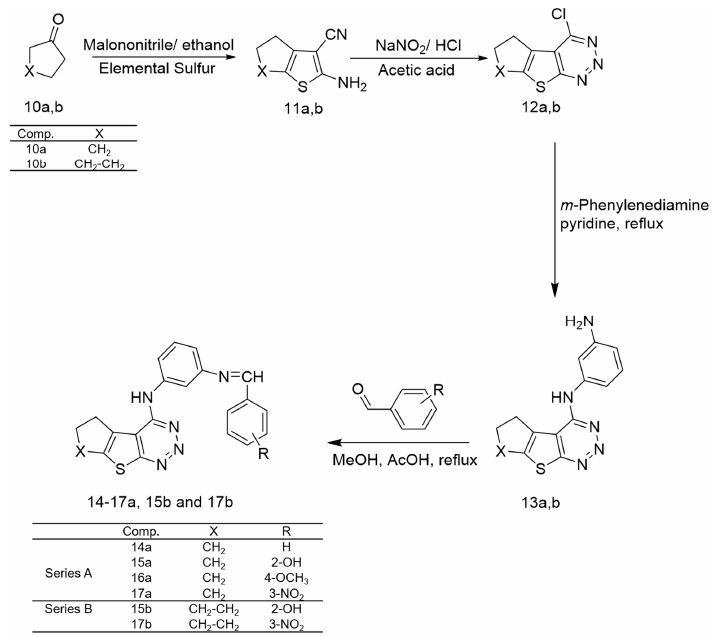
The structures of the synthesized compounds were confirmed by microanalyses and spectral data (IR, 1 H NMR, and EI-MS). Mass spectra showed the expected molecular ion peaks. IR spectra of the synthesized compounds ( 21a , b ) collectively showed secondary amine signals at around 3300–3500 cm − 1 , which indicates coupling between 2-chloro- N -(3-